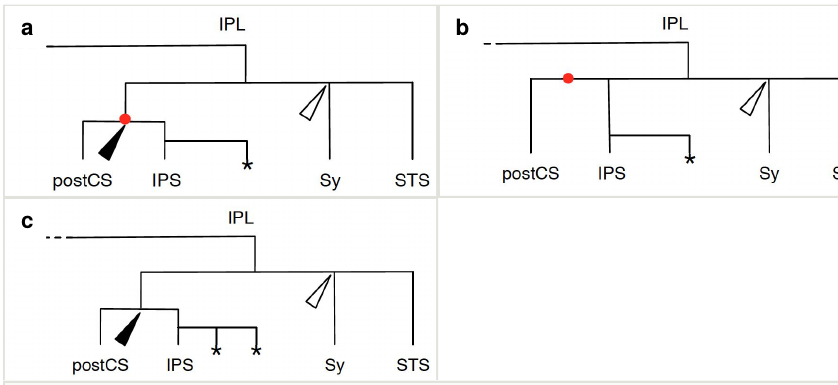
These three diagrams correspond to the three folding patterns in Fig. 3 (left to right): typical, PreSMG, and PreAG. Red dots indicate a critical node that distinguishes the typical and PreSMG folding